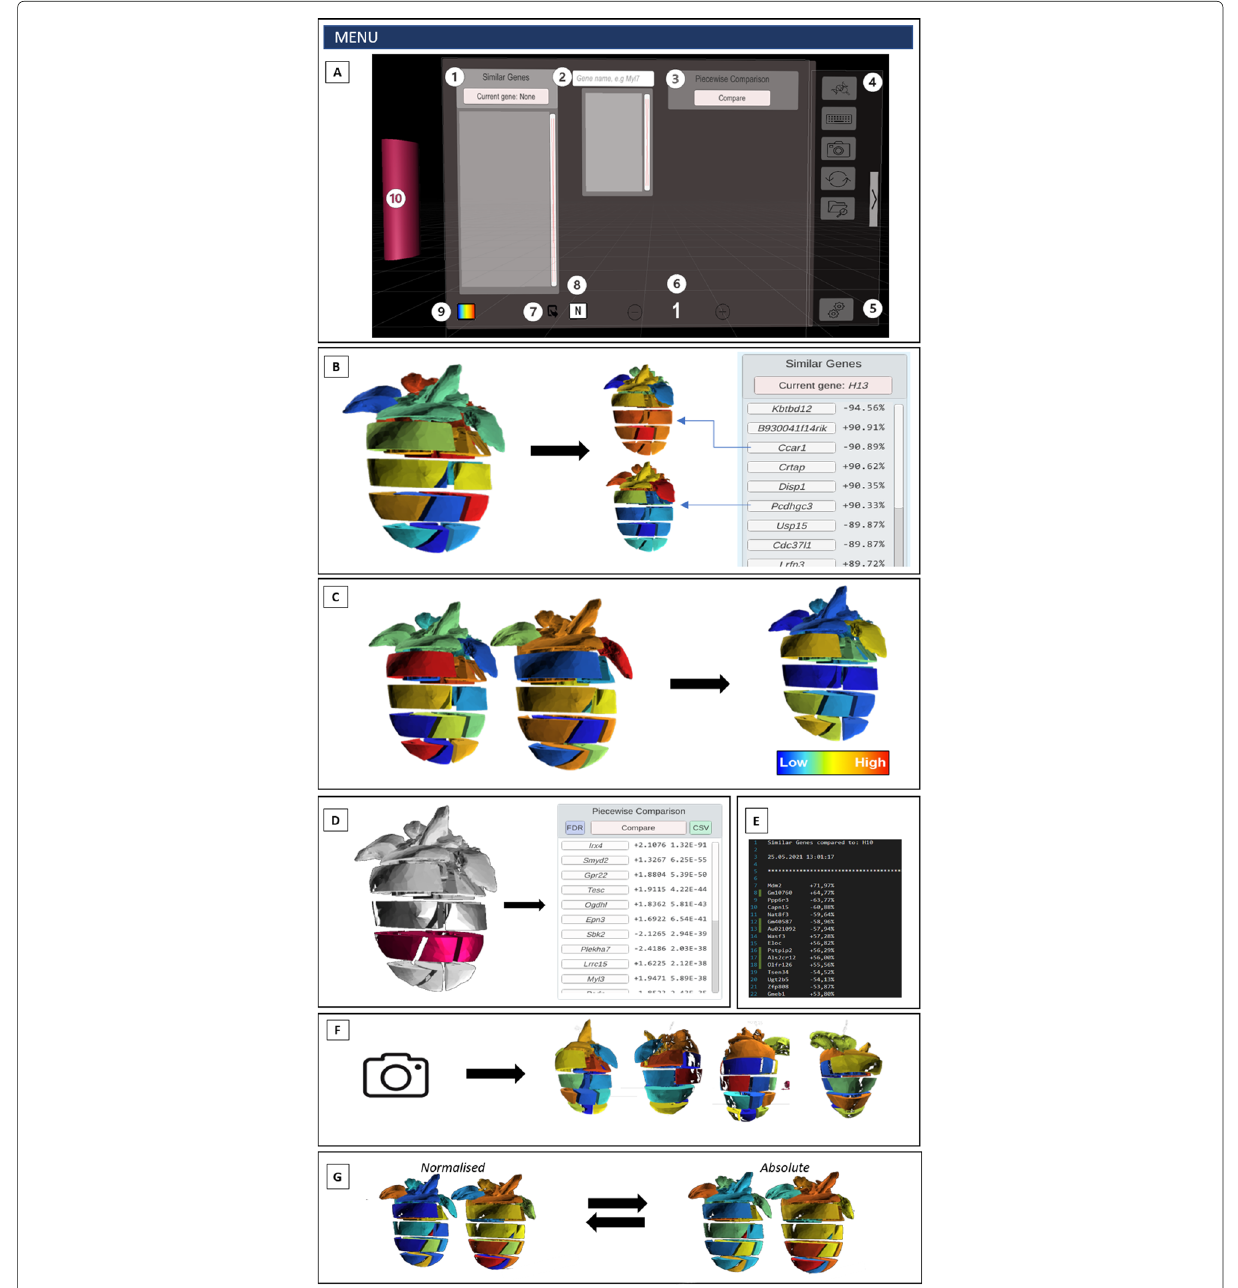
Fig. 3 Features and functions of VR-Cardiomics. A) VR-Cardiomics menu panel (HMD-VR), with all features of VR-Cardiomics, which are also valid for an FTVR with the exception of features 4,5,6, and 10. 1) A sorted list of genes with similar expression patterns as the selected gene. 2) Search bar with complete auto features. 3) Piecewisecomparison/groupselection feature. 4) Sidebar panel, functions from top to bottom: switch to current view of menu panel, toggle virtual keyboard, screenshot function, reset, and dataset selection. 5) Settings menu. 6) Add or remove 3D objects to or from the environment. 7) Export SimilarGenes list. 8) Toggle between absolute or normalized expression pattern visualization. 9) Color spectra for expression patterns. 10) Handle used to move the menu panel B) Visualization of a gene expression pattern in the heart model with an example of a resulting similar gene list. C) Side-by-side comparison of two different gene expression patterns (left) and heatmapcomparison of two genes within one model based on the differences in the gene expression values in each section (right). D) Piecewisecomparison/groupselection to analyze the gene expression based on the regions within the model. E) Similar gene list exported as text files. F) Example of a screenshot from four different angles of the heart model. G) Comparison of visualization of normalized and absolute